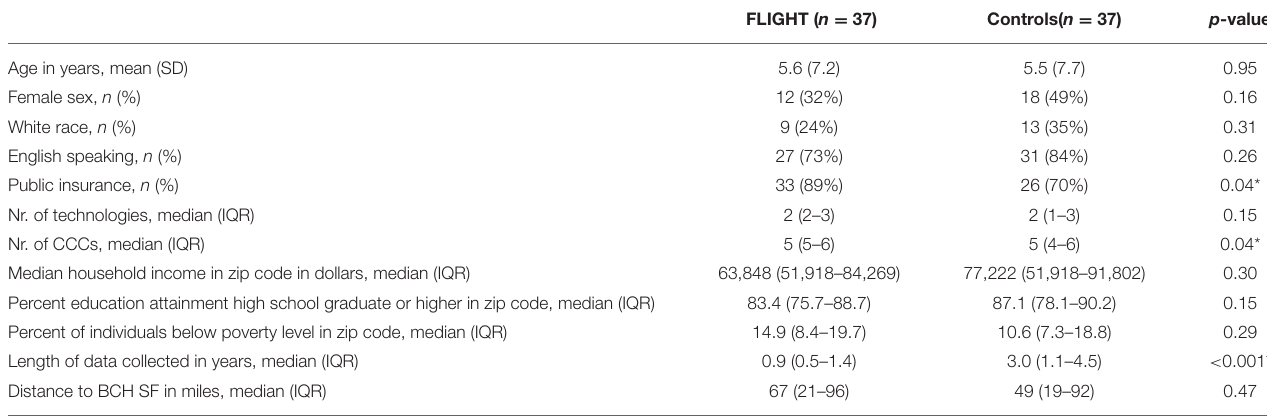
TABLE 1 | Baseline characteristics of FLIGHT and Control